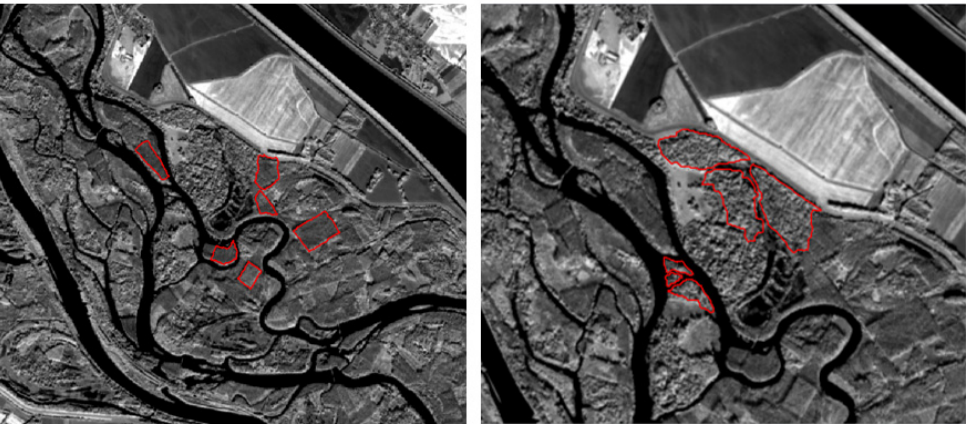
Figure 7. Segments of poplar plantations ( left ) and Natura 2000 habitat 91E0 floodplain forests ( right ) in the area of Danube inland delta.